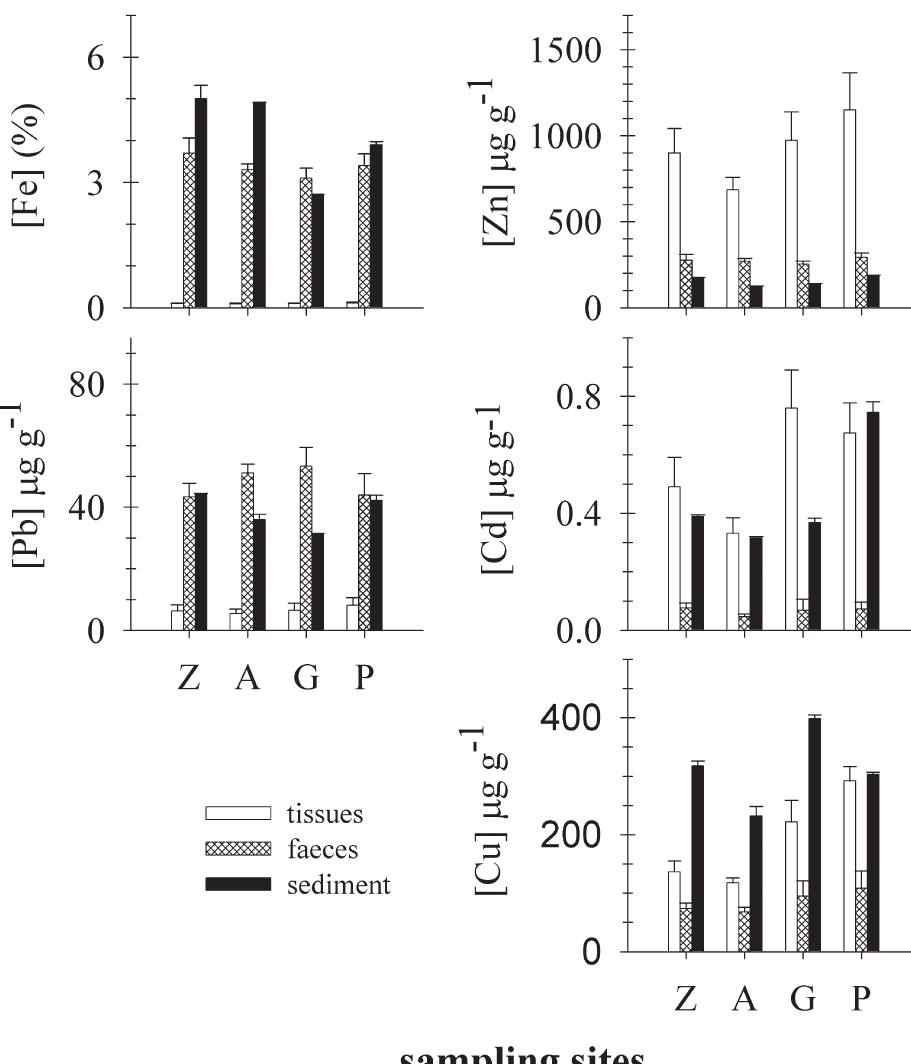
Fig . 3. – relationships between average concentrations of Fe, Zn, cu. Pb and cd (µg g -1 dry weight) in sediment (n =12), worm tissues and faeces (Z =780 w.; a =680 w.; G =660 w.; P =660 w.) in sampling stations. w -